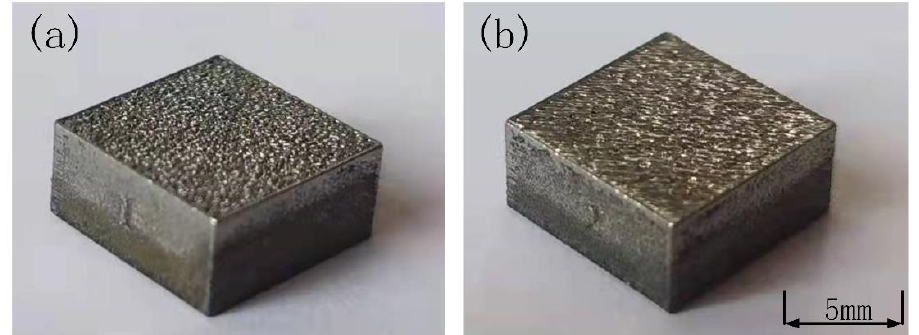
Figure 1. Macroscopic morphology of sample. ( a ) As-SLMed; ( b ) ILPed. The parameters of SLM were 185 W, 0.6 m/s and 0.05 mm and 0.01mm (power, speed, spot diameter and hatch spacing). The parameters of ILP were 180 W, 0.6 m/s and 0.05 mm and 0.01mm (power, speed, spot diameter and hatch